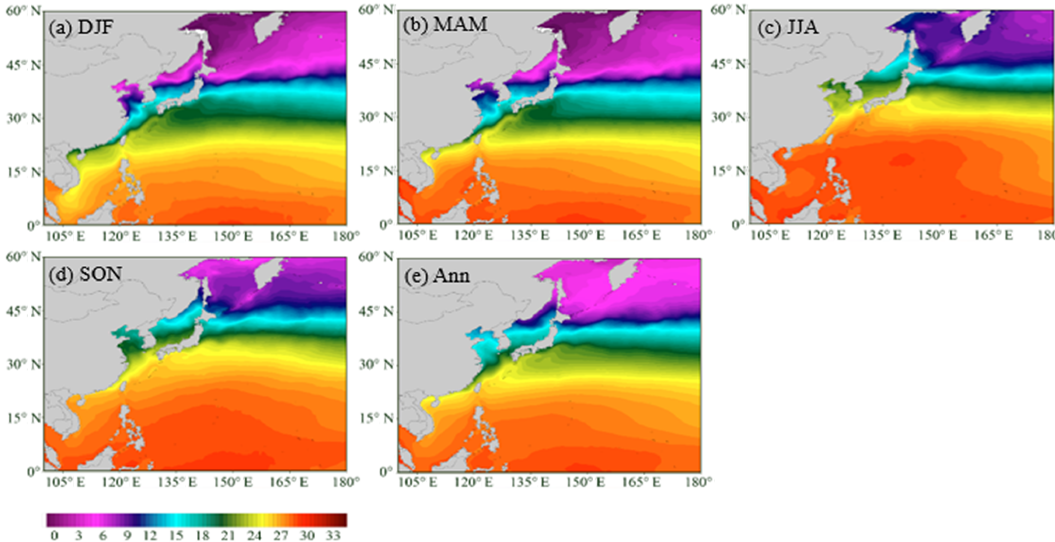
Figure 7. Spatial distribution of seasonal/annual SST over the 1988–2017 period: (a) winter: DJF; (b) spring: MAM; (c) summer: JJA; (d) autumn: SON; (e)